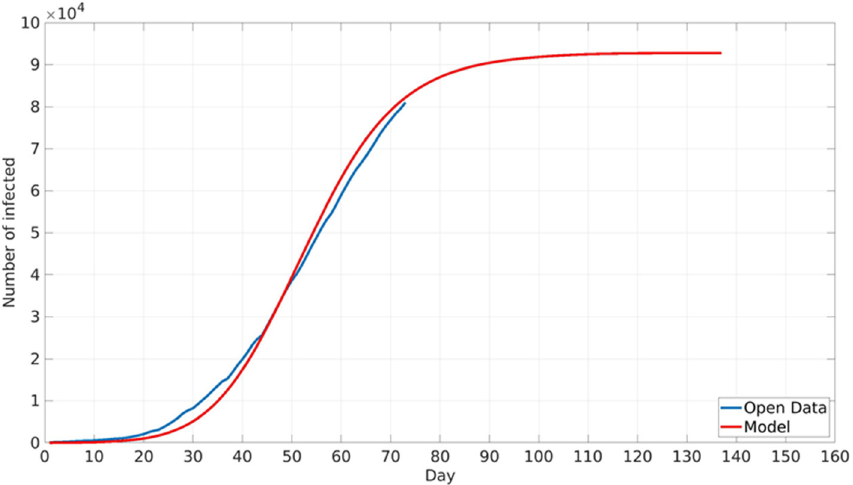
Figure 4. Comparison between cumulative numbers of reported real-life and modelled COVID-19 cases. Real-life data are marked with the blue line, modelled data are marked with the red line.